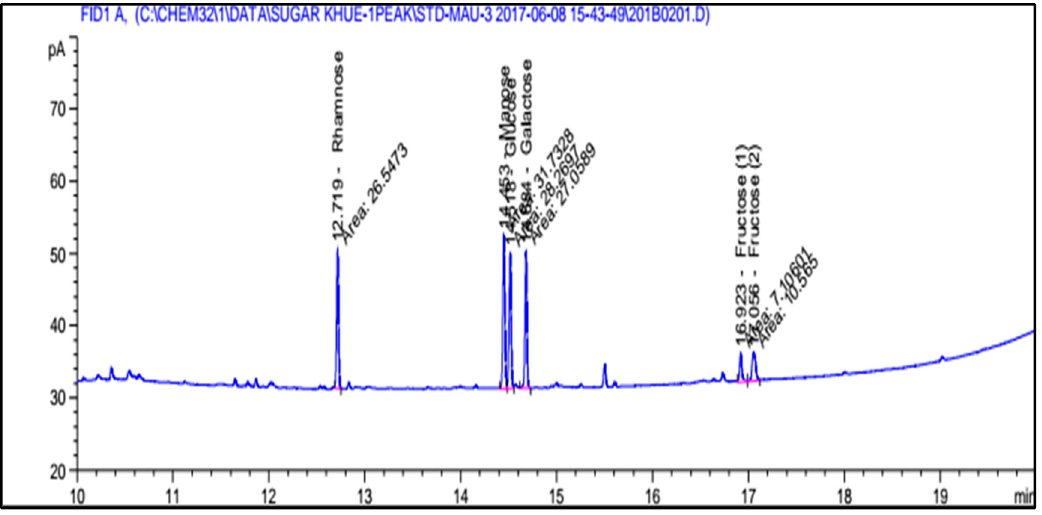
Figure 3. Sugar composition of antioxidant